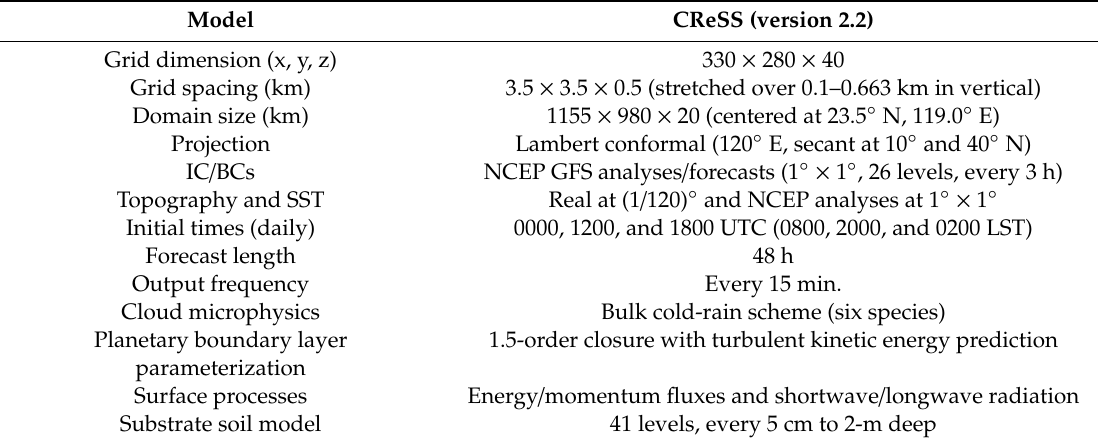
Table 1. Summary of configurations, initial and boundary conditions (ICs / BCs), and major physical options used in the CReSS model (version 2.2) for routine forecasts during the Mei-yu